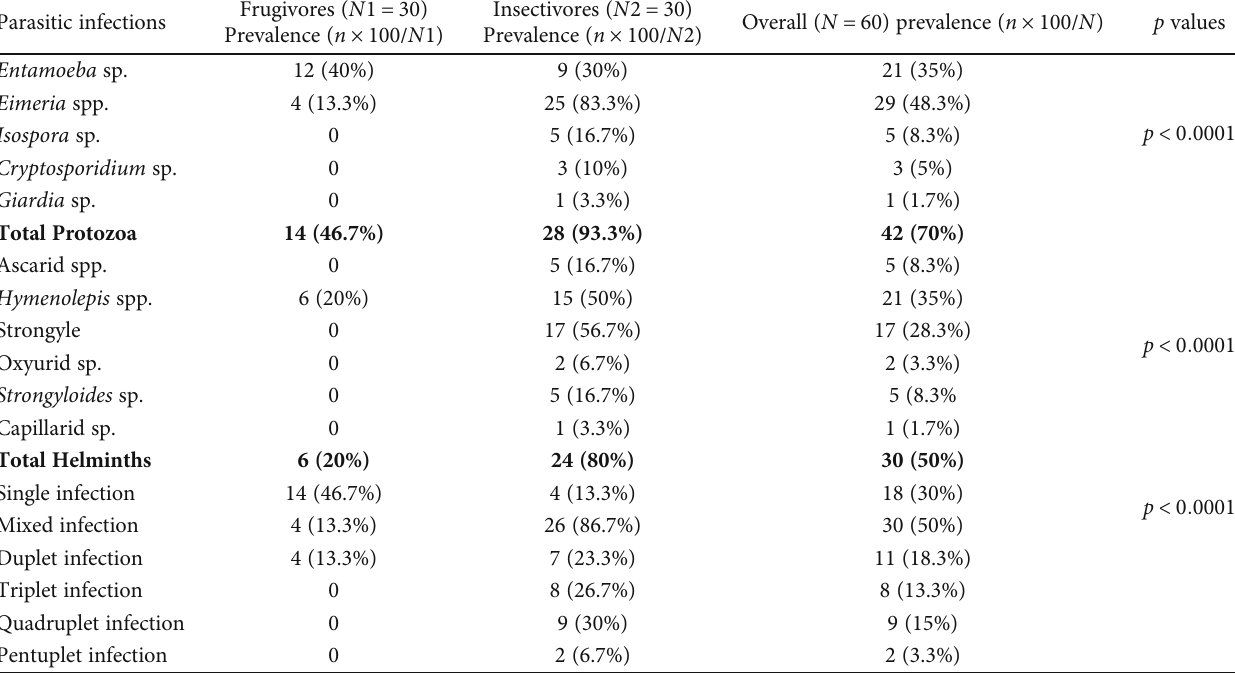
Table 1: Parasitic species, their concurrency, and prevalence in the frugivorous and insectivorous bats in Southcentral Nepal. Fisher ’ s exact test (two-tailed) was used to calculate the p values by comparing the prevalence rates of di ff erent parasitic species or groups between the frugivores and insectivores. Frugivores ( N 1 = 30 ) Insectivores ( N 2 = 30 ) Parasitic infections Overall ( N = 60 ) prevalence ( n × 100/ N ) p values Prevalence ( n × 100/ N 1 ) Prevalence ( n × 100/ N 2 ) Entamoeba